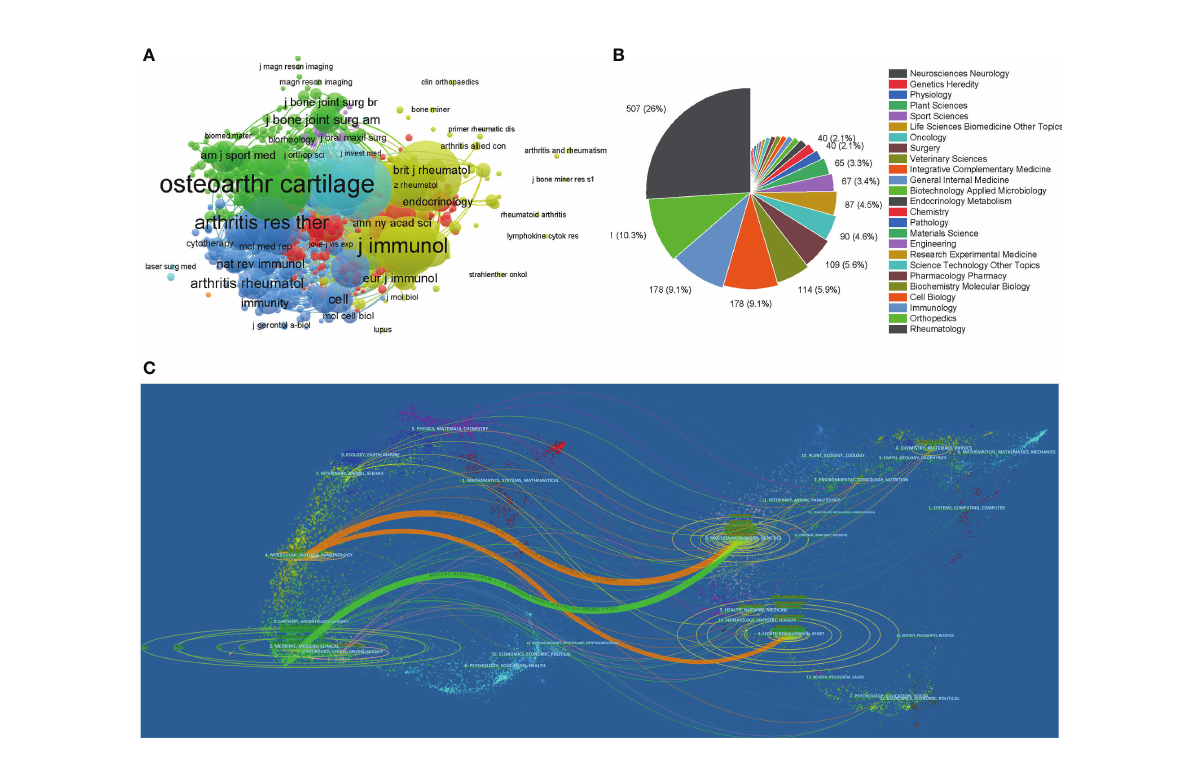
mechanism research (dark blue), cluster 5: pathological features (orange), and cluster 6: surgery research (light blue). These results exhibited the most prominent research topics in macrophages associated with osteoarthritis so far. In the